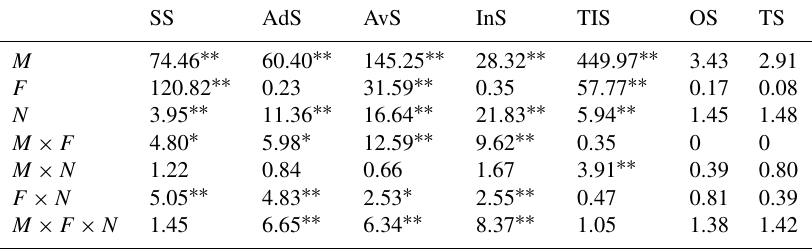
Table 2. Results of three-way ANOVAs ( F value) for the effects of mowing ( M ), N addition frequency ( F ), and intensity ( N ) on soil sulfur (S) fractions and total S concentration.